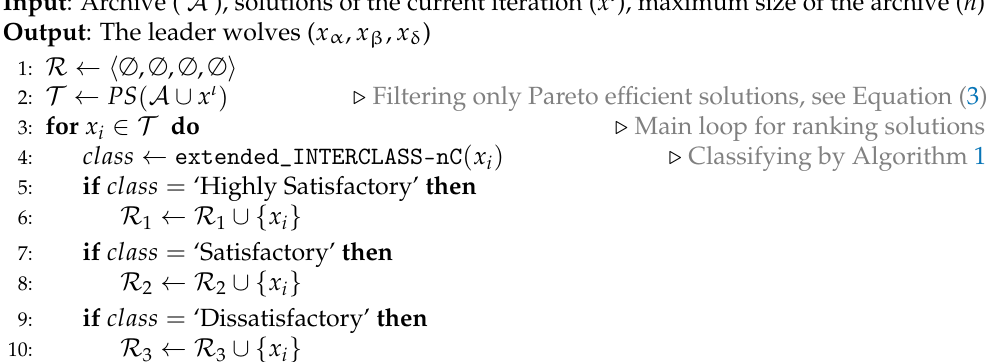
Algorithm 2 Selection of the leader